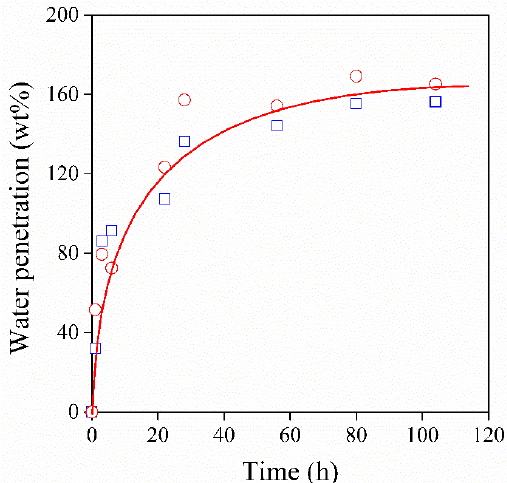
Figure 7. Time dependence of the penetration of water into PLA disks compressed from electrospun fibers. Symbols: ( ◯ ) PLA containing 0.96% Amox, ( ◻ ) neat PLA.